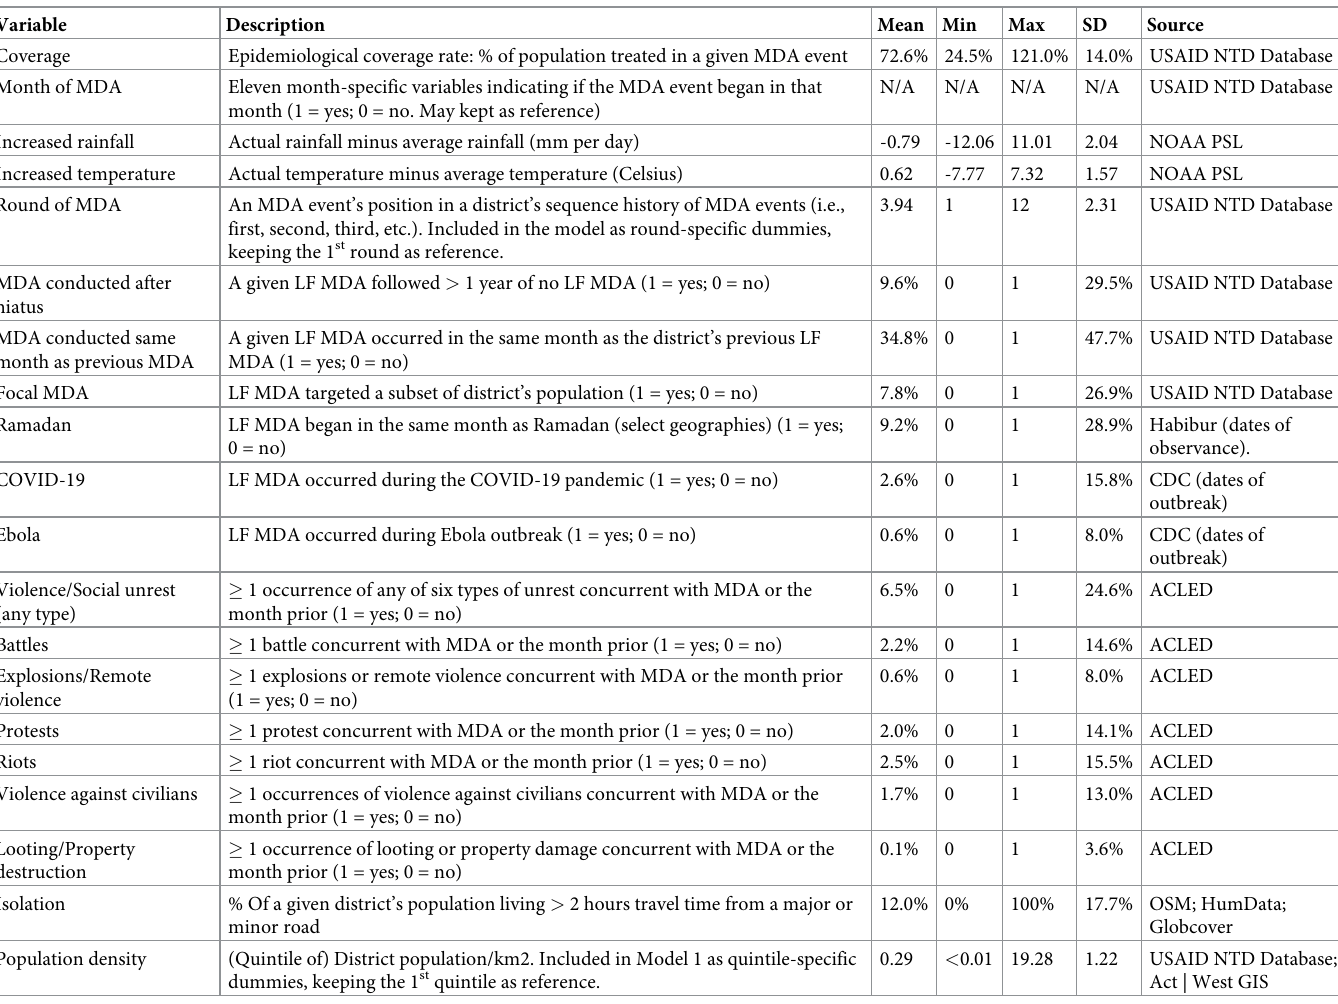
Table 1. Summary of variables included in